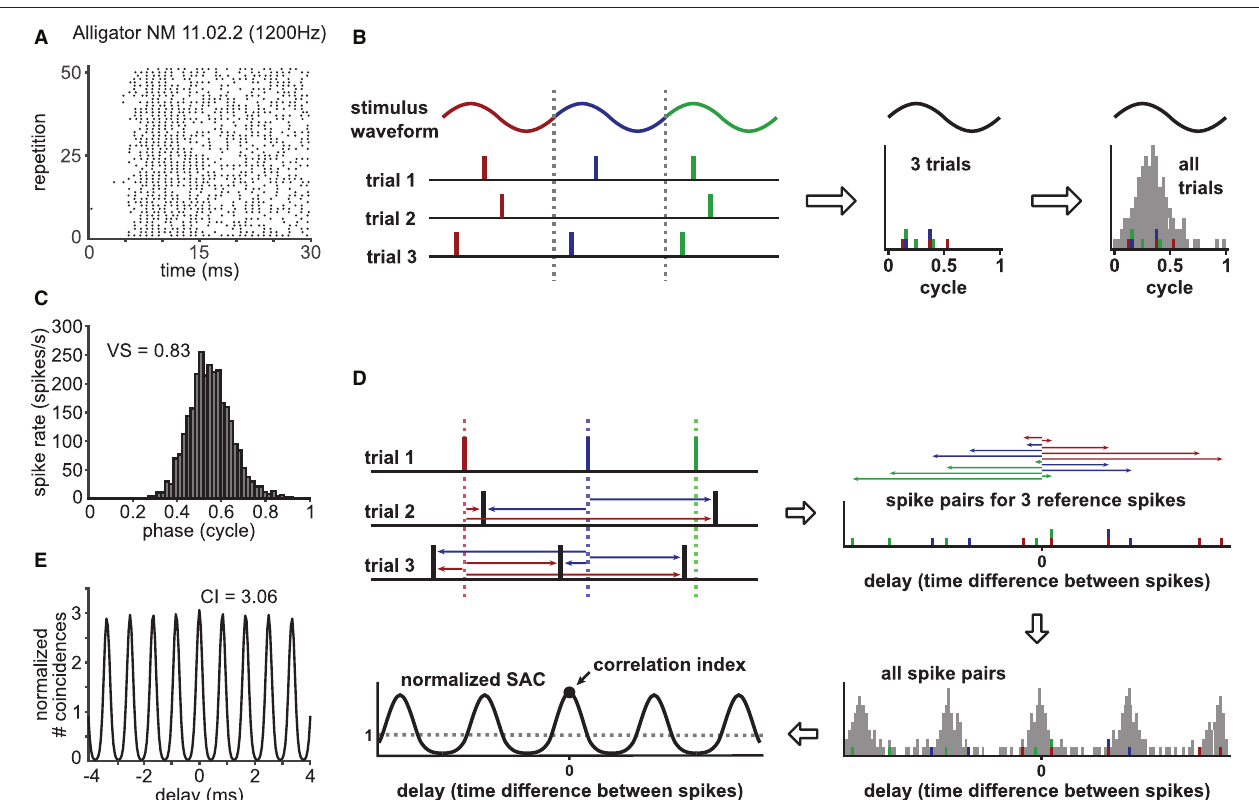
FIGURE 1 | Characterization of phase-locked spiking response. (A) Exemplary phase-locked spike trains recorded in a nucleus magnocellularis (NM) neuron of an American alligator. The raster plot shows the occurrence of spikes for 51 (out of 63) repetitions of a 100 ms pure tone stimulus at the unit’s CF (1200 Hz). Sound stimulation starts at 0 ms. (B) Schematic drawing for the construction of a phase histogram. For each recorded spike, the corresponding phase at the reference frequency is calculated. Then, a histogram is constructed to show the number of spikes for each phase bin. A steep peak indicates strong phase-locking, whereas a flat phase histogram reflects a lack thereof. (C) Phase histogram for the response in (A) with its vector strength (VS) value. (D) Schematic drawing for the construction of a normalized shuffled autocorrelogram (SAC). Each spike timing within one spike train (here, exemplary trial 1) is compared to the spike timings of all other trains (here, trial 2 and 3) by measuring pairwise temporal distances of the spikes (colored arrows). This procedure is repeated for every recorded spike train. All resulting temporal distances, also called delays, are binned into a histogram and normalized to a dimensionless entity with an average of one. The correlation index (CI) corresponds to the value of the SAC at delay zero. (E) SAC for the response in (A) with its CI